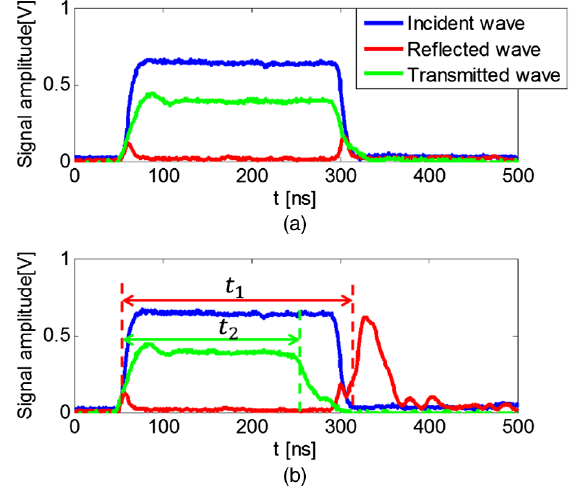
FIG. 5. Detected signals in Nextef. (a) Normal rf pulse signal and (b) typical breakdown signal. t 1 is the rising edge of the reflected wave, whereas t 2 is the falling edge of the transmitted wave. t 1 and t 2 are used for breakdown cell location and breakdown timing calculation.